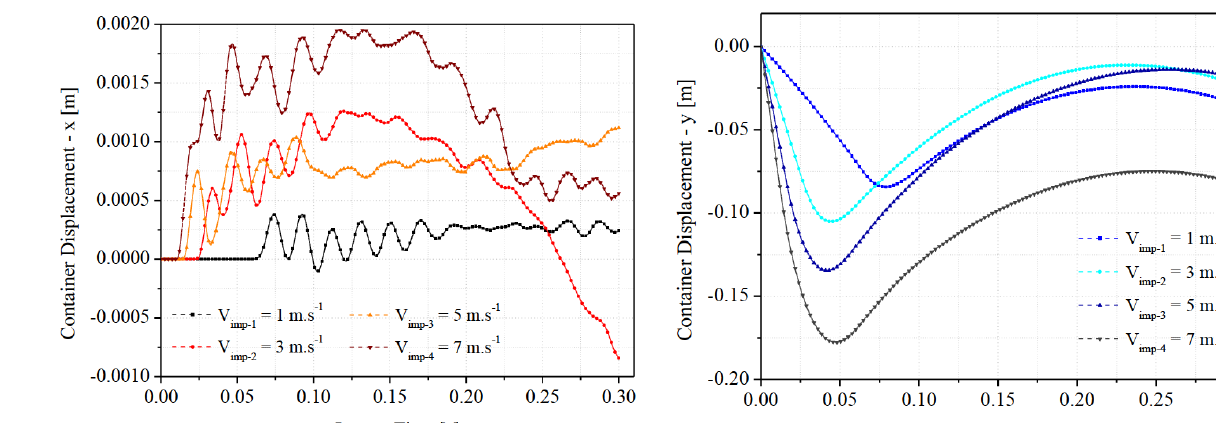
tudecausesearlierdamageoccurrenceonthecargo,which